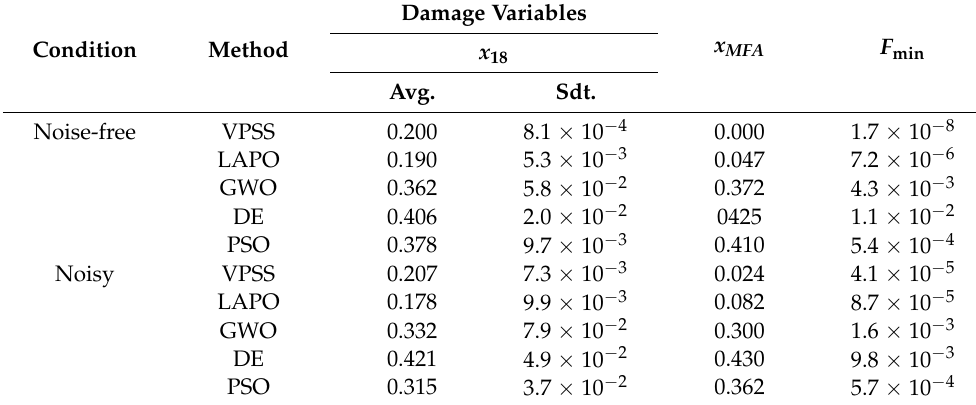
Table 6. Statistical results of the damage identification for the Canton Tower.